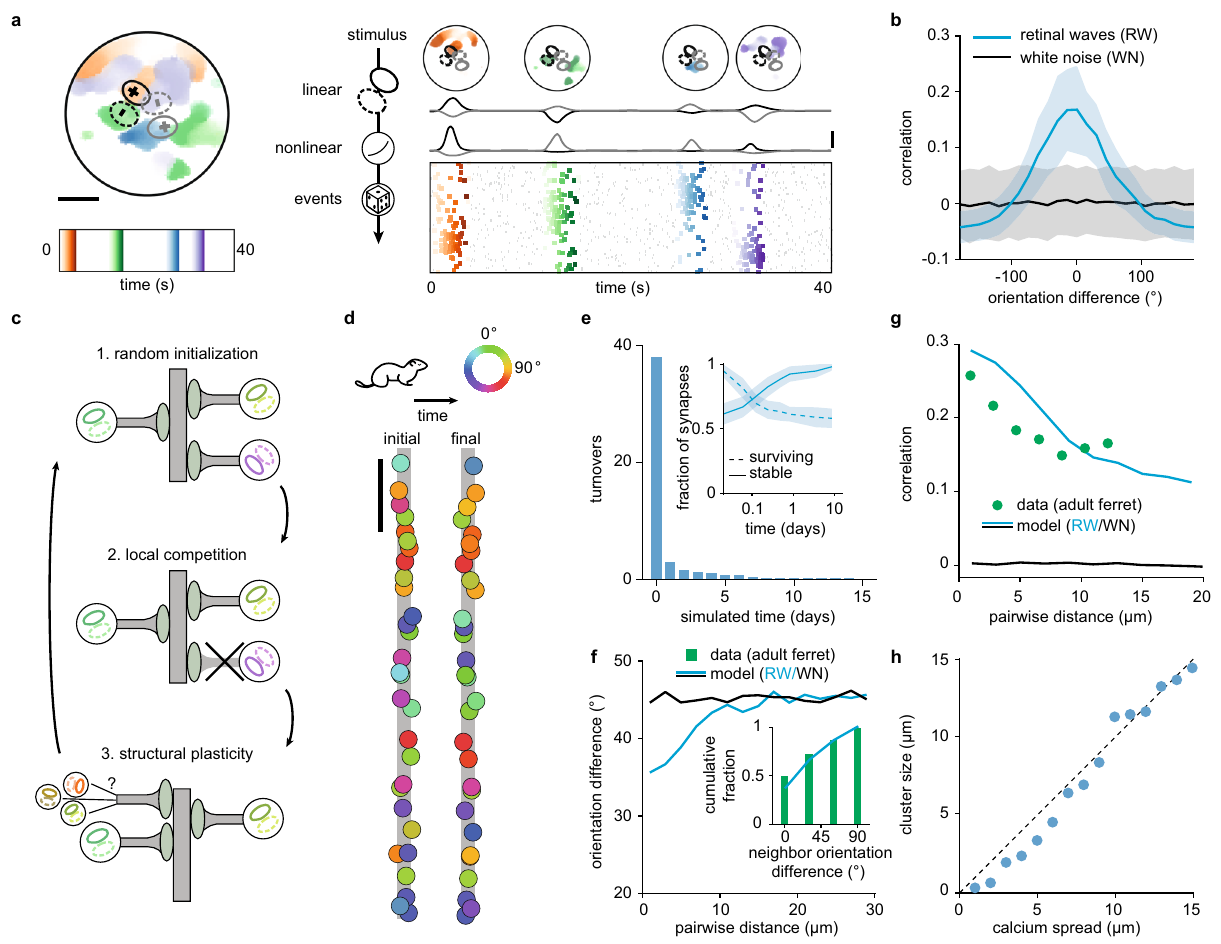
Fig. 3 Retinal wave input and synaptic turnover produce orientation clustering on a dendritic branch in a model of the ferret visual cortex. a (Left) Illustration of 40 s of retinal wave input. The color gradients indicate different time points. Scale bar is 30° in visual space. Superimposed are two schematics of Gabor receptive fi eld fi lters with positive (full line) and negative (dashed line) components. (Right, from top) Four spontaneous retinal waves as stimuli, linearly fi ltered responses, and nonlinear outputs for the two oriented Gabors on the left. Scale bar is 1 Hz. Rows in raster plot correspond to fi ring events from different receptive fi elds, sorted from top to bottom by orientation. Gray events represent background noise. b Mean correlation as a function of the difference in orientation of receptive fi elds stimulated with retinal waves (RW) or white noise (WN) input. Shaded area indicates standard deviation. c Local correlation- and distance-dependent competition, together with structural plasticity, drive the formation of synaptic clusters. d Example of the emergence of orientation clustering on a linear dendrite using ferret cortex receptive fi eld diameter and center distribution with retinal waves over 2 simulated weeks. Color of synapses indicates the orientation preference of the associated receptive fi eld. Scale bar is 20 μ m. e Number of turnovers as a function of simulated days. Inset: Semi-log plot of the mean survival fraction (synapses present at the beginning of simulation) and the stable fraction (synapses present at the end of the simulation) as a function of simulated days. Shaded area indicates standard deviation. f Orientation difference between pairs of synapses as a function of distance in the model with retinal waves or white noise. Inset: Cumulative fraction of orientation difference between an individual synapse and its nearby neighbors (less than 3 μ m away) in the model and experiments (data from adult ferret visual cortex reproduced from ref. 7 ). Difference computed after taking the orientation modulo 180° (see Methods). g Correlation between pairs of synaptic inputs in the model driven by retinal waves or white noise, and correlation between calcium signals of spontaneous synaptic activity (data from adult ferret visual cortex reproduced from ref. 9 ) as a function of distance. h Cluster size computed as the standard deviation of the best Gaussian fi t to the pairwise correlation vs. distance (see Methods and g ), as a function of the postsynaptic calcium spread. Dashed line indicates the identity